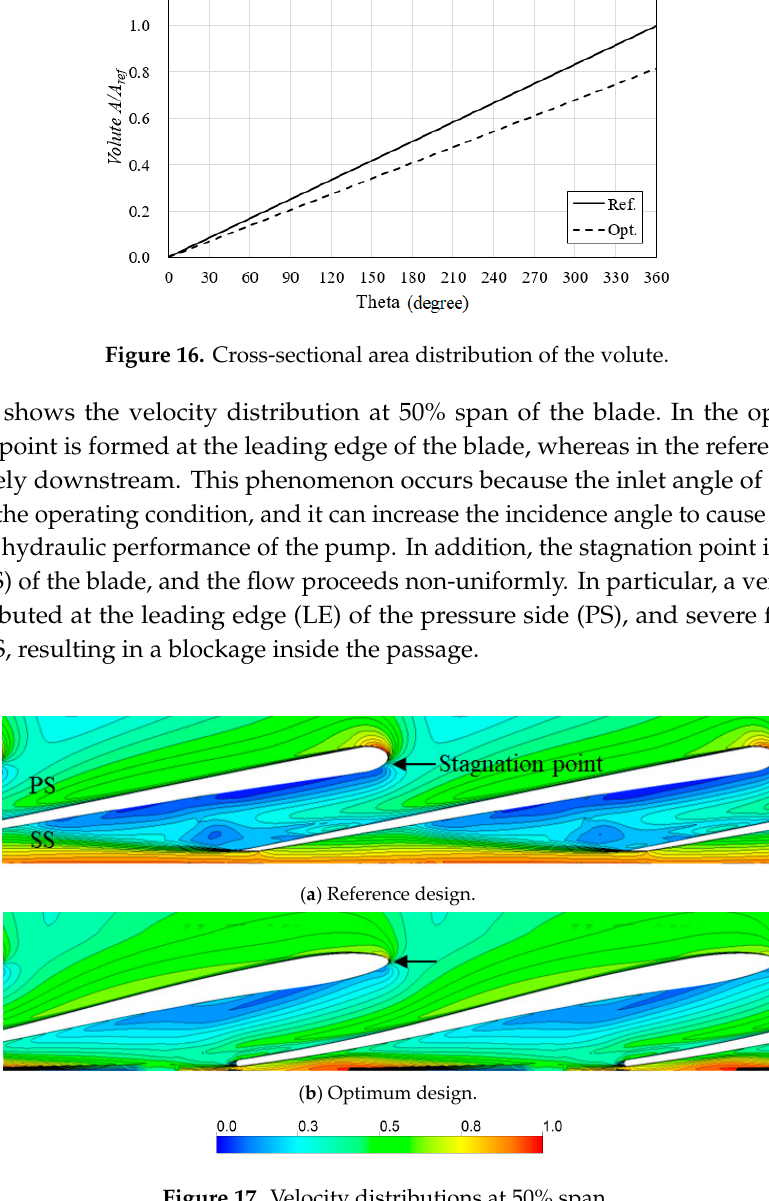
Figure 17. Velocity distributions at 50% span.